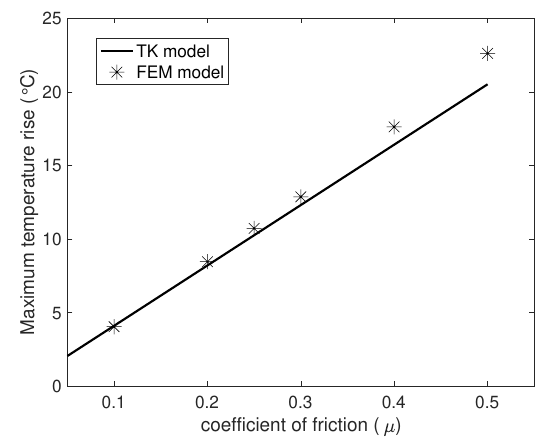
Figure 3 . Maximum temperatures estimated from the theoretical (TK) model and the FEM model at di ff erent values of coe ffi cient of friction .